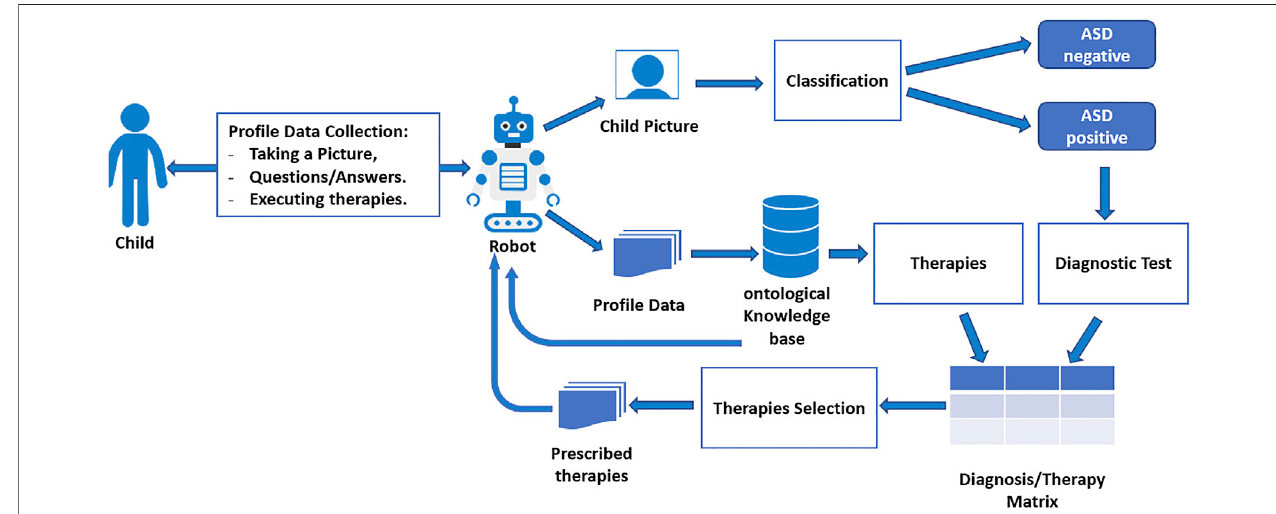
FIGURE 1 | Overview of the therapy procedure with robots for children with ASD.